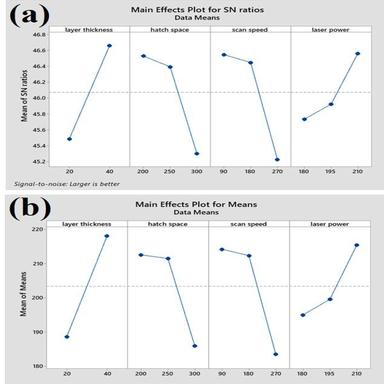
(a) The S/N ratio and (b) mean values for the effective parameters on the average indentation micro-hardness measurements as determined by S/N and ANOVA analyses.